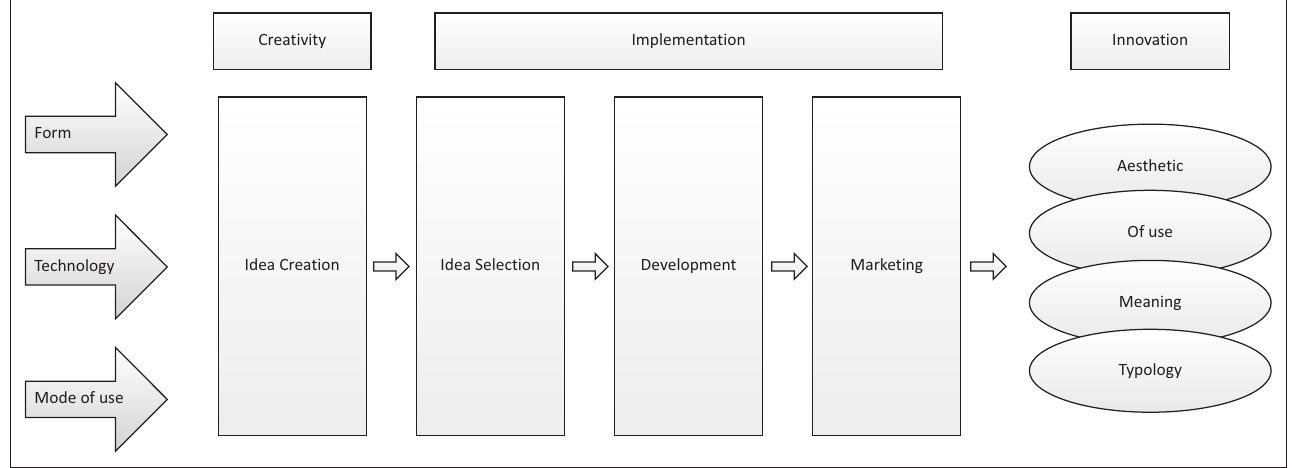
FIGURE 1: Design innovation